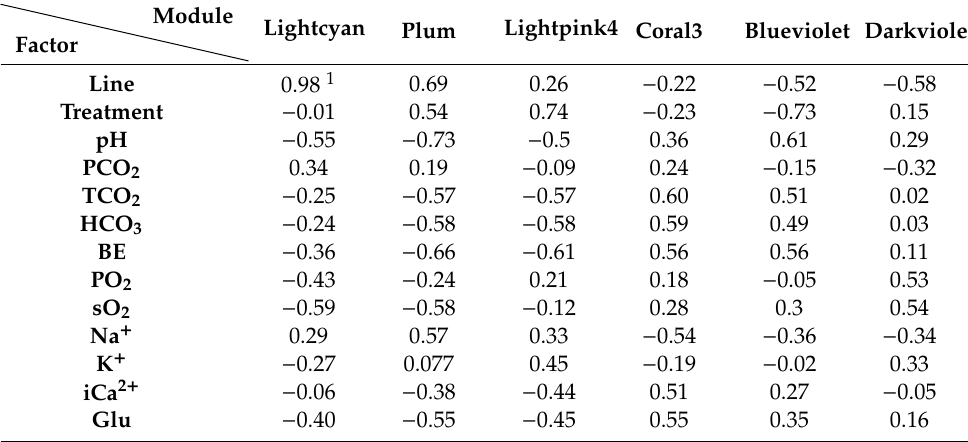
Table 4. Gene modules that were significantly associated with factors (line, treatment or blood phenotypes) under the AH